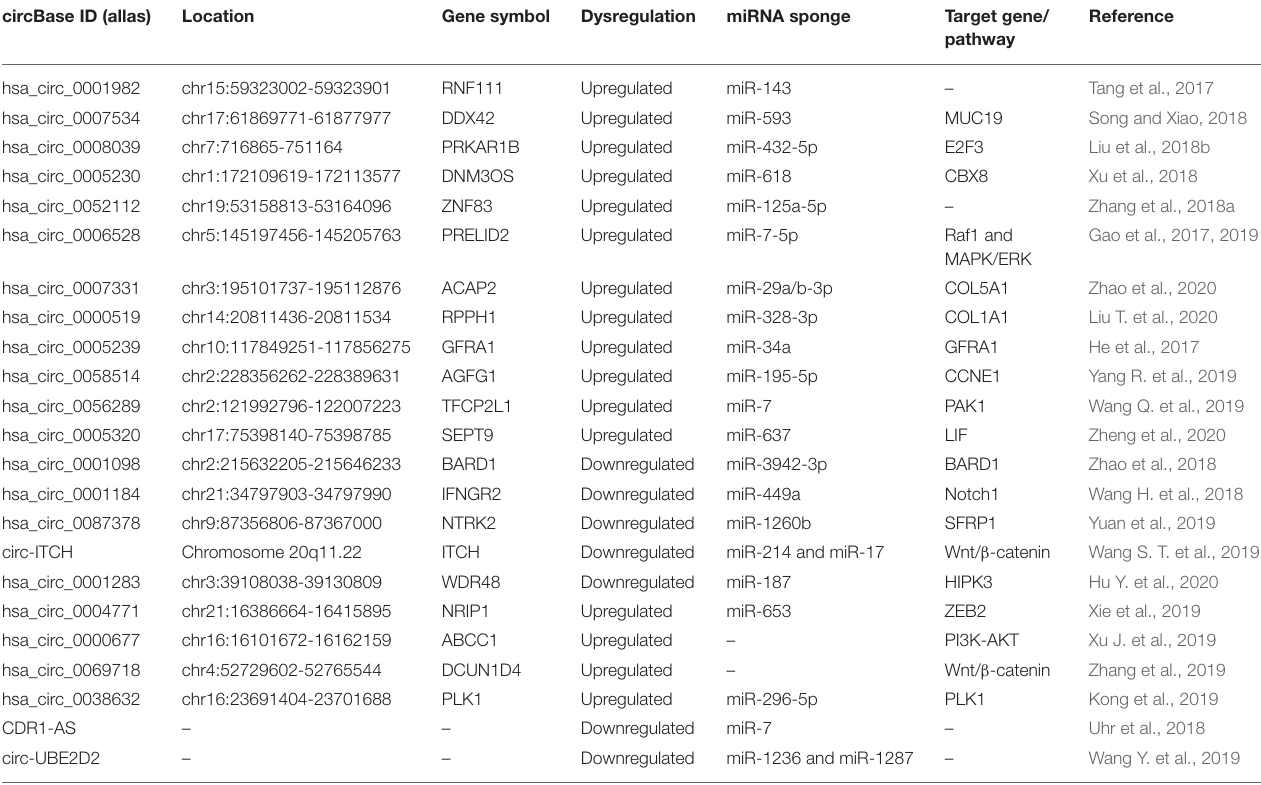
TABLE 1 | The dysregulated circRNAs and their mechanisms in breast cancer